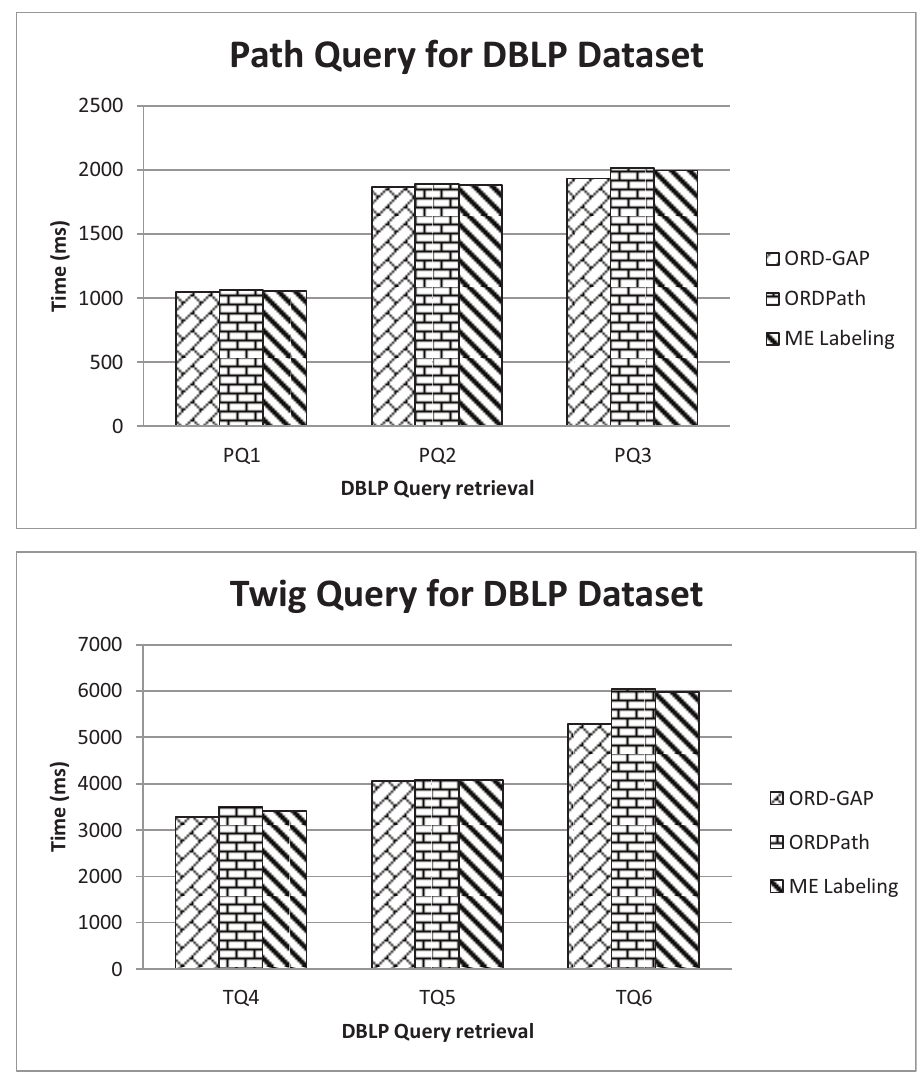
Figure 5. Query retrieval time on DBLP